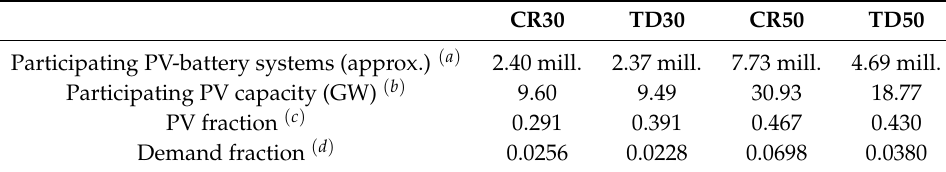
Table 3. Parameters involved in the demand adjustment due to energy storage in the future